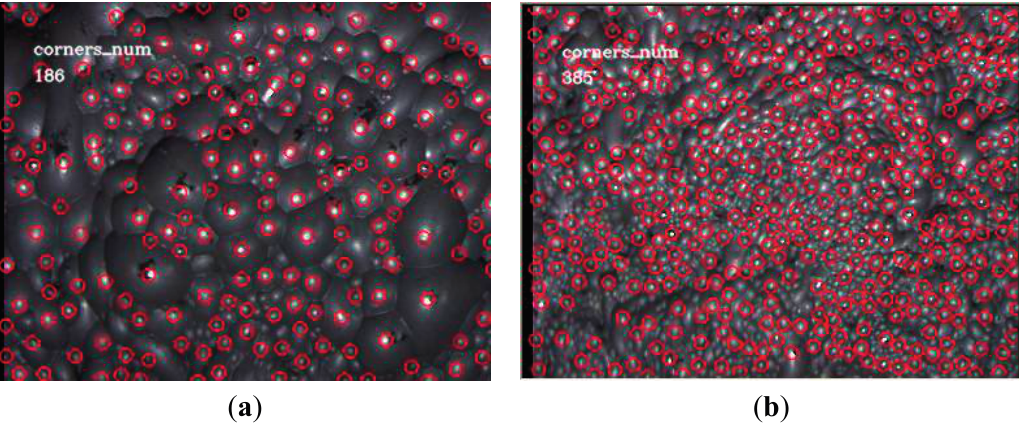
Figure 8. Improved Harris corner point detection. ( a ) Result of the large bubbles with tolerance distance 15; ( b ) Result of the small bubbles with tolerance distance